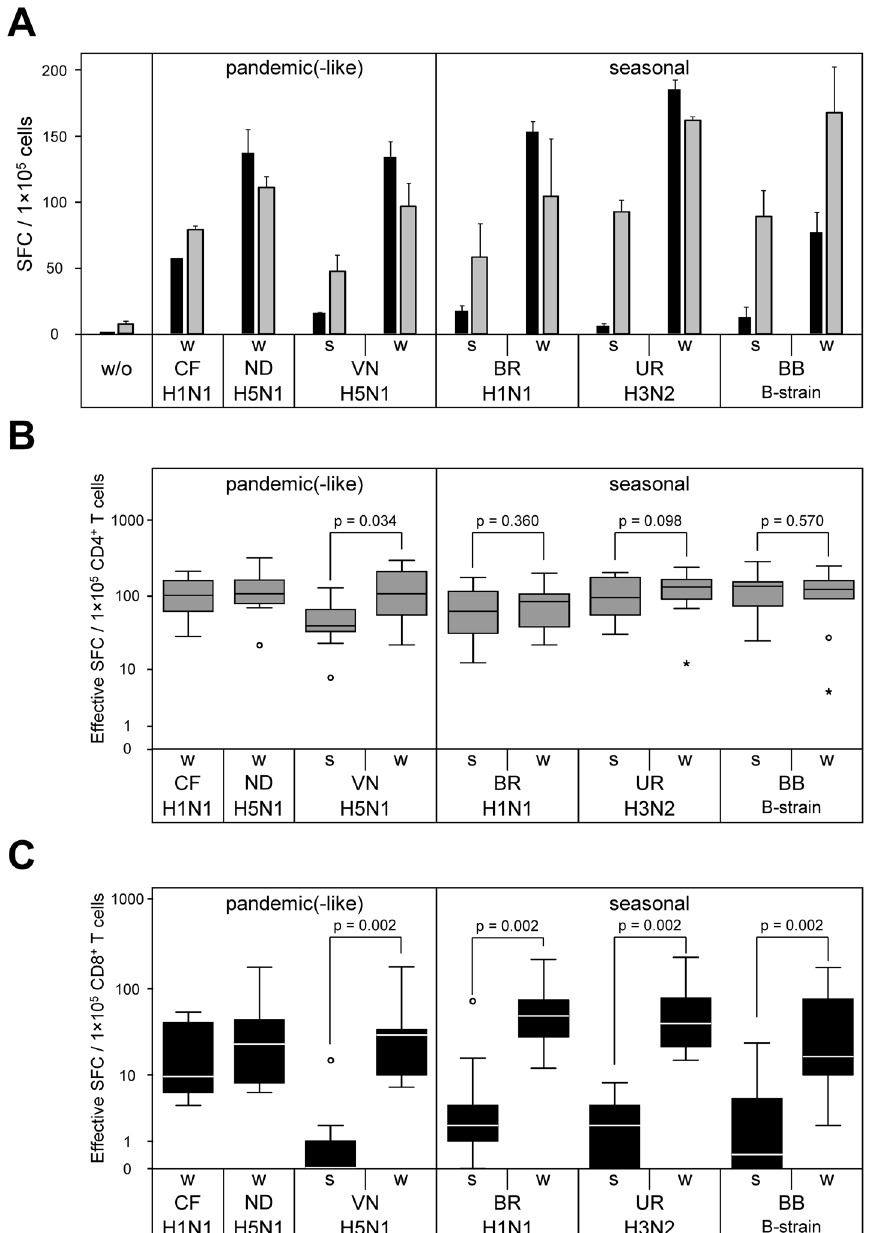
Figure 3. CD8 + T-cell reactivity to whole virus is superior compared to split virus preparations. CD4 + and CD8 + T cells purified from PBMC of healthy individuals were screened for IFN- c ELISpot reactivity to autologous DC pre-loaded with 10 m g/mL of influenza whole virus and related split virus vaccine formulations. DC also received maturation cytokines during vaccine pulsing. (A) Representative data obtained from donor HD20 with 1 6 10 5 CD4 + T cells (grey columns) or 1 6 10 5 CD8 + T cells (black columns) plated per well are shown. (B, C) Reactivity to influenza whole virus and related split virus vaccines were measured in 10 randomly selected healthy individuals as described in (A). Box plot diagrams include IFN- c ELISpot data from purified CD4 + (B) and CD8 + (C) T cells. Effective SFC were determined by subtraction of background spot numbers (w/o vaccine) from spot numbers induced by each individual vaccine. P -values were calculated by two-tailed paired-sample Wilcoxon signed-rank test.